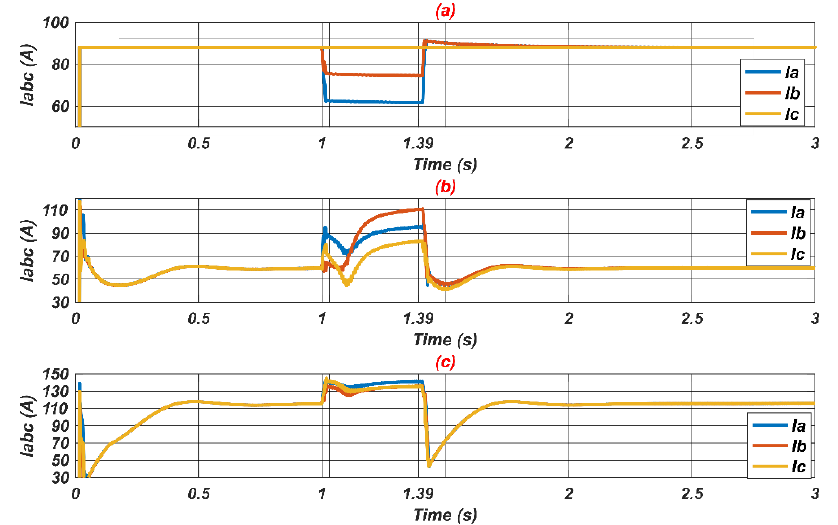
Figure 11. RMS three-phase currents for phase B-to-ground short-circuit on: ( a ) B_12 without GCPVS, ( b ) B_12 with GCPVS, ( c ) GCPVS output terminal.